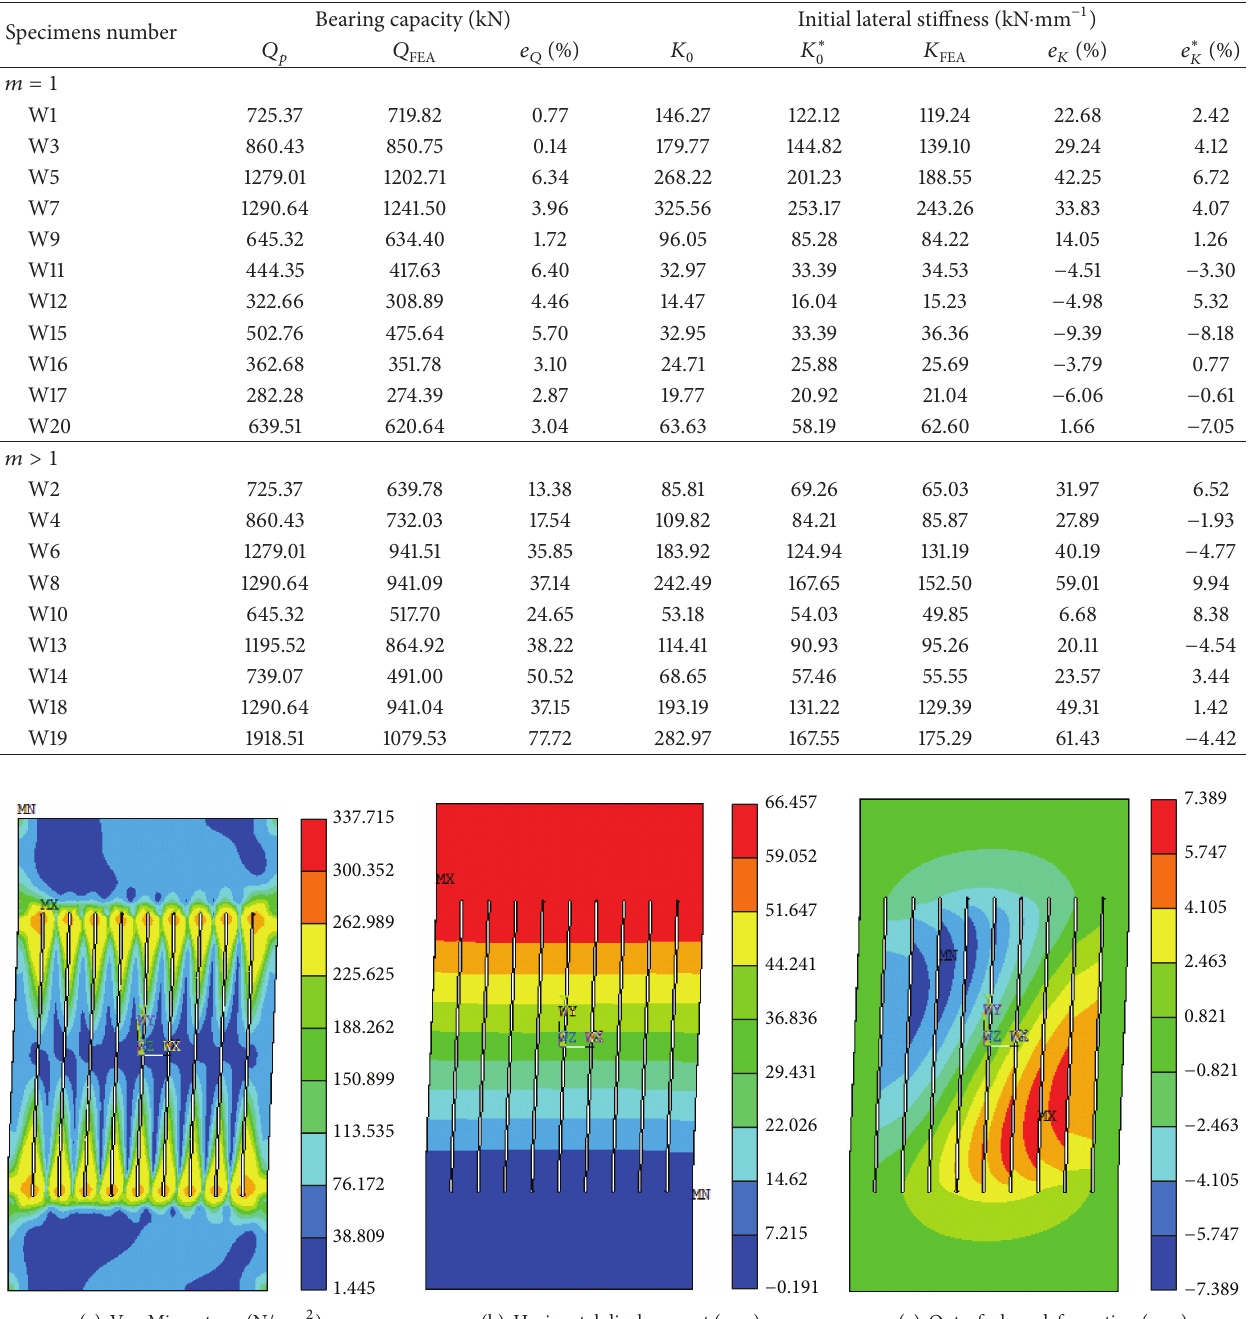
Table 2: Initial lateral stiffness and the bearing capacity of the steel slit wall.